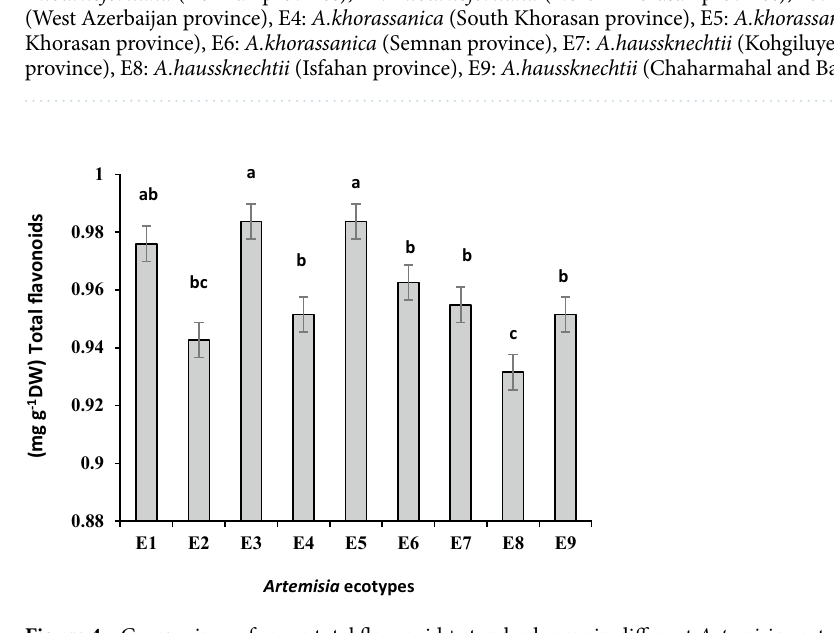
Figure 4. Comparison of mean total flavonoid ± standard error in different Artemisia ecotypes. E1: A.tournefortiana (Kerman province), E2: A.tournefortiana (North Khorasan province), E3: A.tournefortiana (West Azerbaijan province), E4: A.khorassanica (South Khorasan province), E5: A.khorassanica (North Khorasan province), E6: A.khorassanica (Semnan province), E7: A.haussknechtii (Kohgiluyeh and Boyer-Ahmad province), E8: A.haussknechtii (Isfahan province), E9: A.haussknechtii (Chaharmahal and Bakhtiari